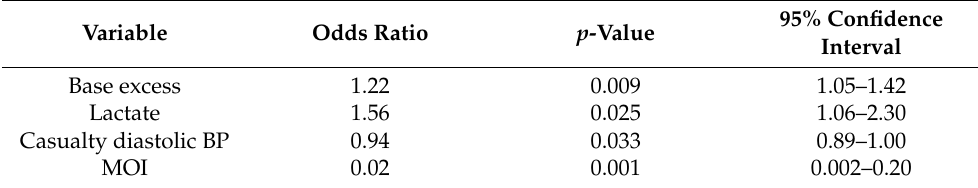
Table 6. Logistical regression for variables that predicted